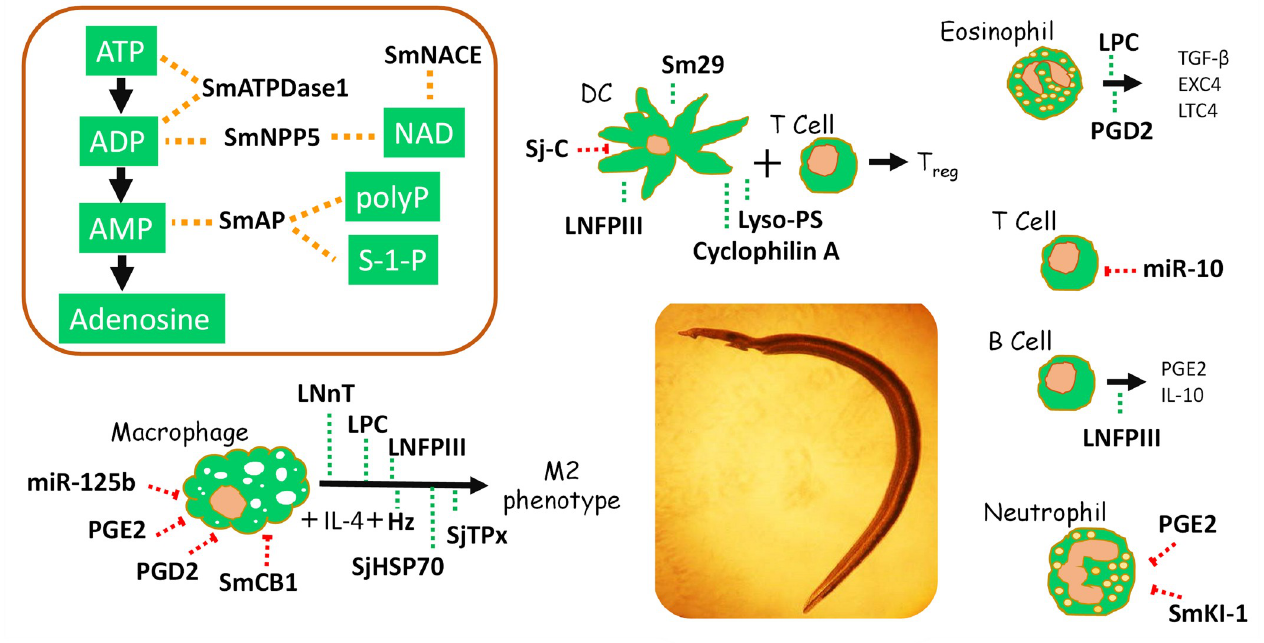
Fig 2. The impact of molecules (bold text) derived from intravascular stage schistosomes (schistosomula and adults) on host cells and metabolites, as indicated. The box (top left) lists S . mansoni tegumental NMEEs and, connected by dashed yellow lines, the host signaling molecules they have been shown to cleave (white text). The green dashed lines indicate stimulatory effects on immune cells, while red dashed lines indicate inhibitory effects. An image of an S . mansoni adult male is seen at center. See text for details regarding the impact of individual schistosome molecules on specific cell types. ATP, adenosine triphosphate; ADP, adenosine diphosphate; AMP, adenosine monophosphate; DC, dendritic cell; Hz, hemozoin; LNnT, lacto-N-neotetraose; LPC, lysophosphatidylcholine; NAD, nicotinamide adenine dinucleotide; NMEE, nucleotide metabolizing ectoenzyme; PGE2, prostaglandin E2; PGD2, prostaglandin D2.